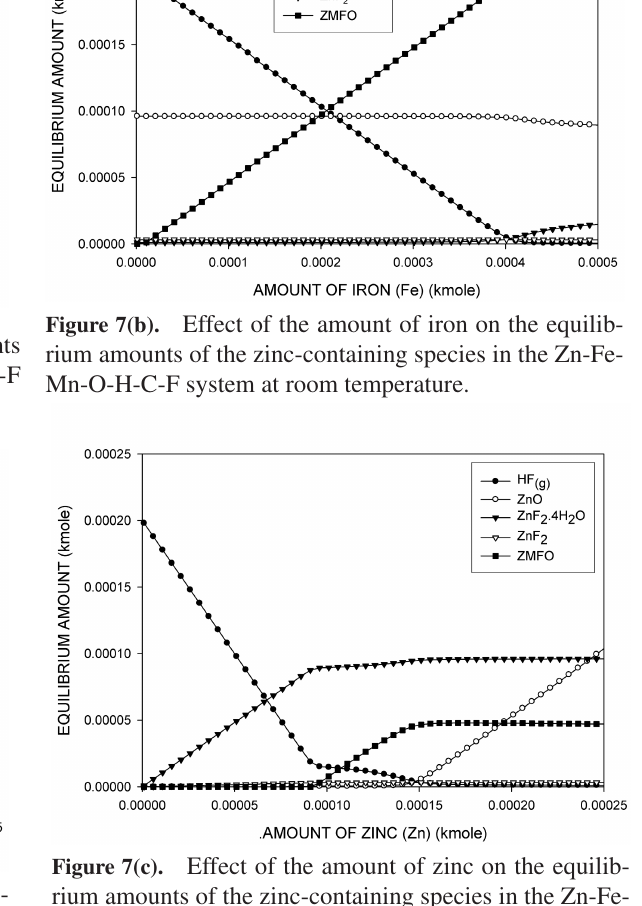
Figure 7(a). Effect of the amount of fluorine on the equi- librium amounts of the zinc-containing species in the Zn- Fe-Mn-O-H-C-F system at room temperature.